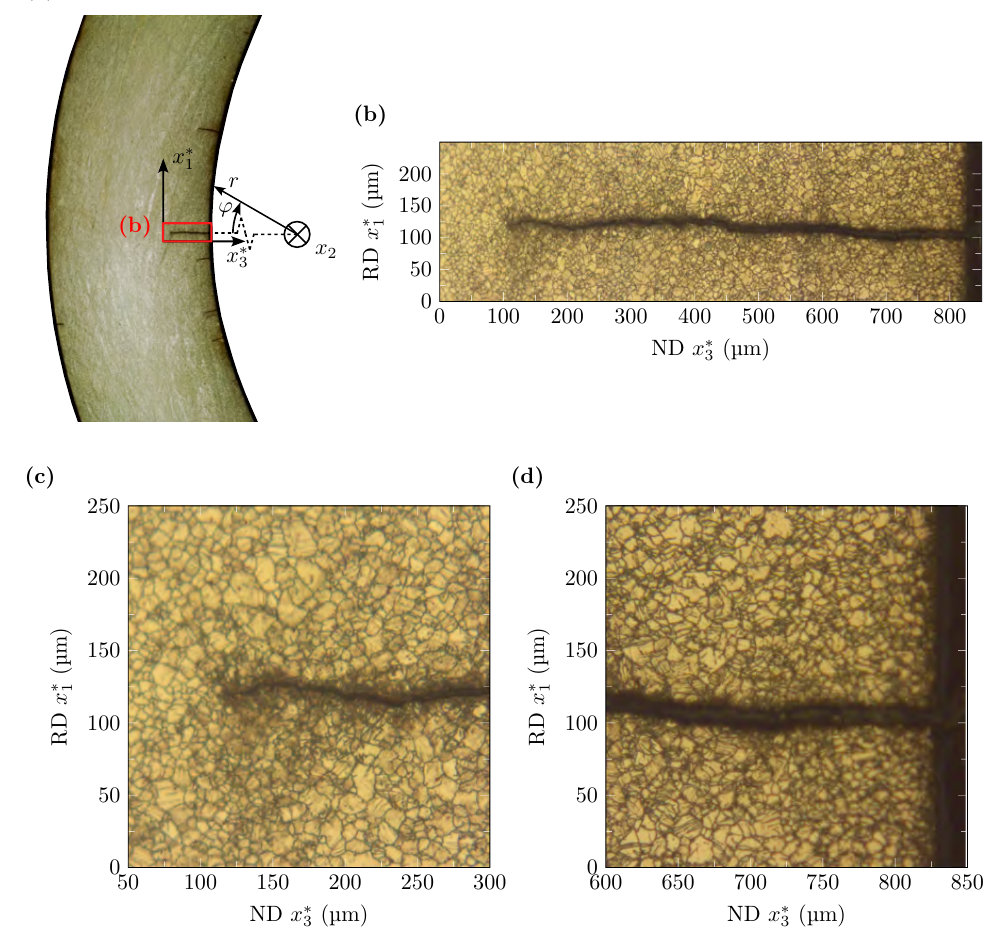
Figure 9. Gauge area and microstructure of the structural component specimen BS9-008 made of AZ31B after cyclic loading with R F = 1 and F a = 1104N: ( a ) overview of the gauge area with visible − cracks; ( b ) crack in the area of twinned grains in the center of the specimen at x 2 = 0; ( c ) magnified view at the crack tip; ( d ) magnified view at the origin of the crack with visible